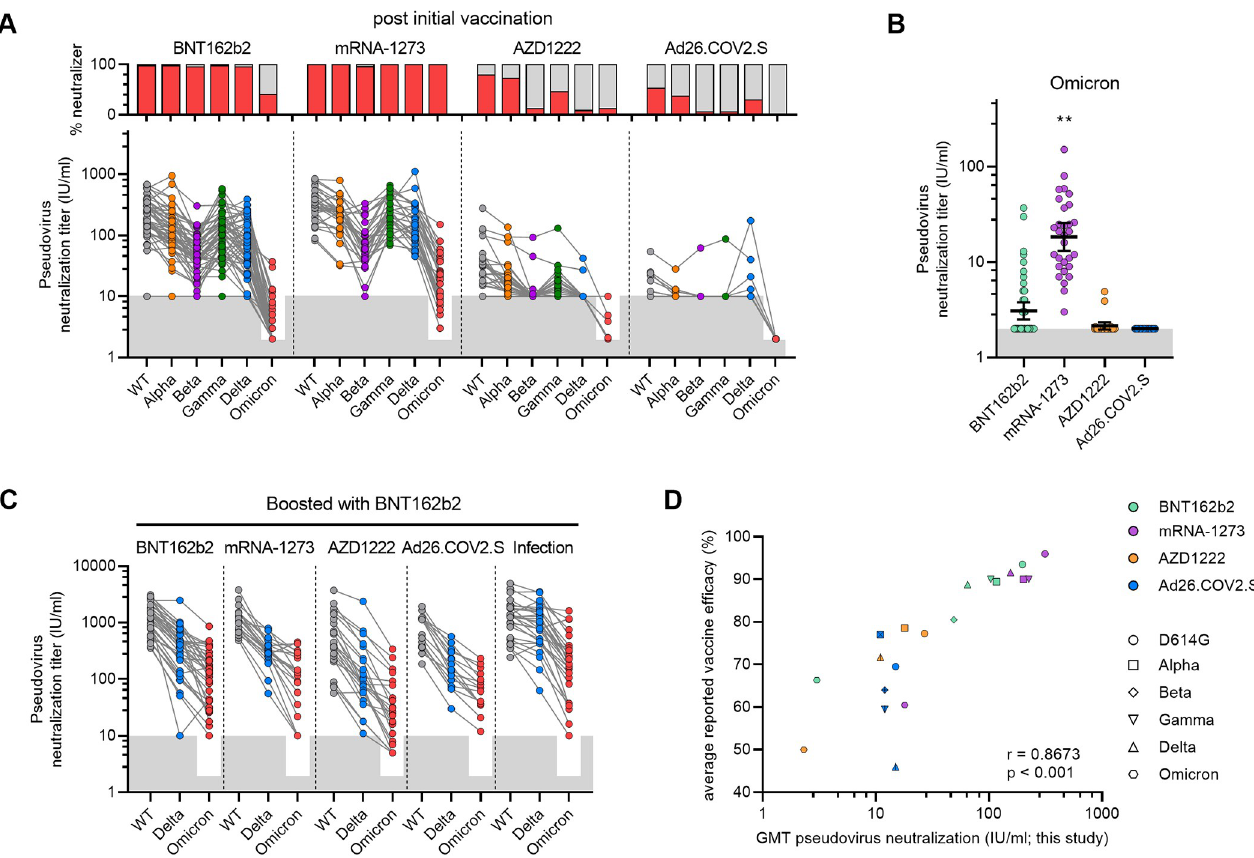
Fig 2. Binding and neutralization titers post-vaccination against VOCs. (A) Paired neutralization IC 50 titers (UI/ml) of D614G and variants of concern (VOCs) pseudoviruses for sera collected post initial vaccination series for the four vaccination groups (lower panel). The lower cut-off for neutralization was set at an half-maximal inhibitory concentration (IC 50 ) of 10 or for Omicron at 2 IU/ml (grey shading). Percentage vaccinee with detectable neutralization titers in red (upper panel). (B) Neutralization titers of Omicron pseudovirus for sera post initial vaccination series. Geometric mean titer (GMT) and 95% confidence intervals (CI) are indicated. The lower cutoff for neutralization was set at an IC 50 of 2 IU/ml (grey shading). �� p < 0.01; linear regression analysis. (C) Paired neutralization IC 50 titers (IU/ml) of D614G and VOCs pseudoviruses for sera collected post booster vaccination for the four vaccination groups and convalescent group (RECoVERED cohort; four weeks after single dose BNT162b2 vaccination up to 15 months post infection, n = 28). The lower cut-off for neutralization was set at an IC 50 of 10 or for Omicron at 2 IU/ml (grey shading). Uni- and multivariable linear regression analysis with GMT and 95% CI results indicated in S4 Table. (D) GMT IC 50 neutralization titers of D614G and VOCs plotted against the average reported vaccine efficacy against symptomatic infection with WT or VOCs (S2 Table). Vaccine groups are indicated by colors with BNT162b2 in green, mRNA-1273 in purple, AZD1222 in orange and Ad26.COV2.S in blue. Circles represent WT data, squares for Alpha, diamond for Beta, nabla triangle for Gamma and delta triangle for Delta. Crossed symbols are at the neutralization cutoff. Spearman’s rank correlation coefficient with p-value are indicated.